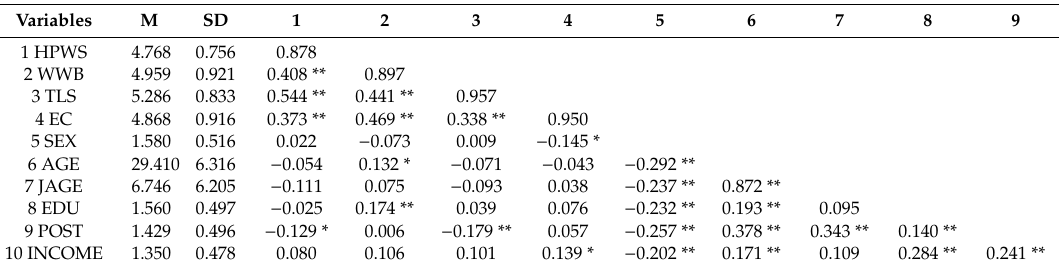
Table 3. Mean, standard deviation, and correlations of variables a,b